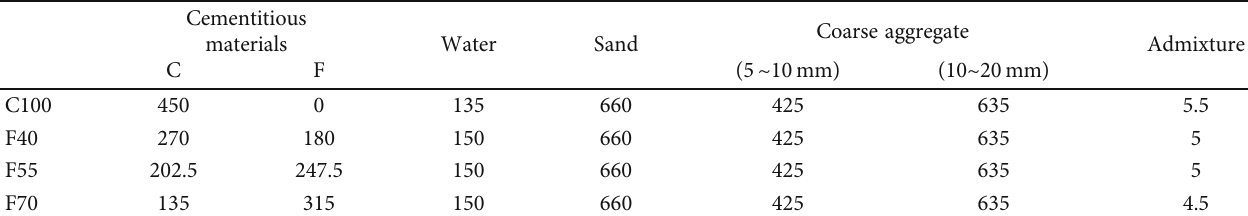
Table 3: The proportions of the mixtures in the C60 concrete (0.3 water-cement